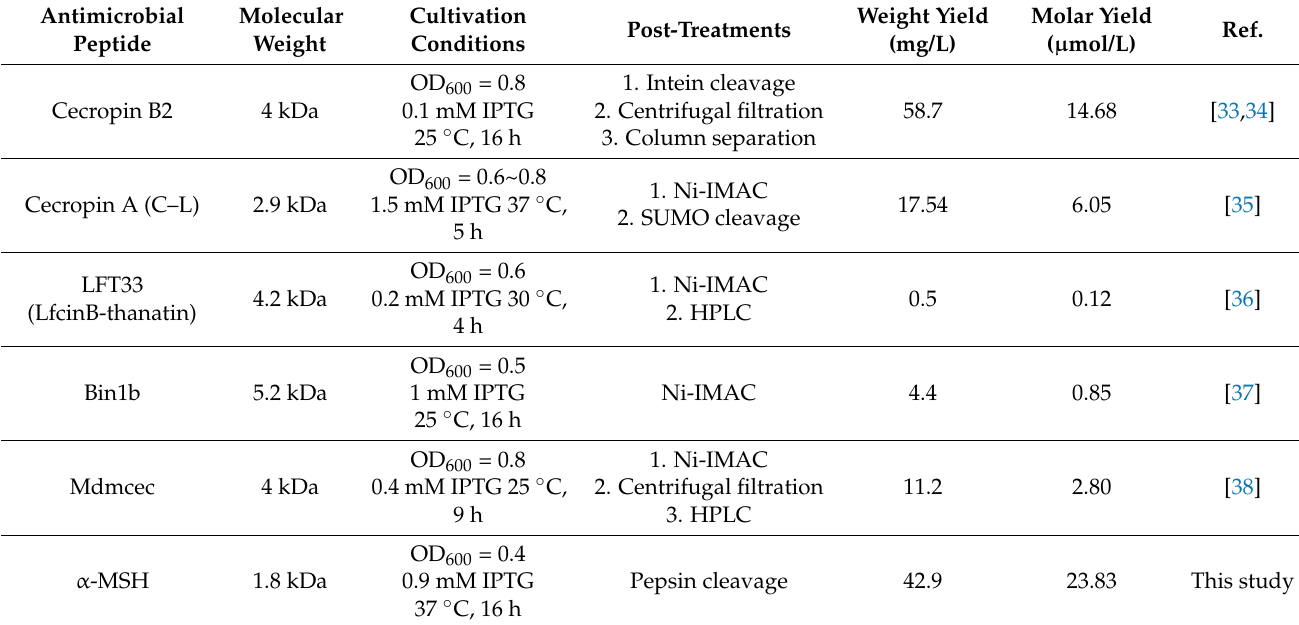
Table 6. Comparison of antibacterial peptide